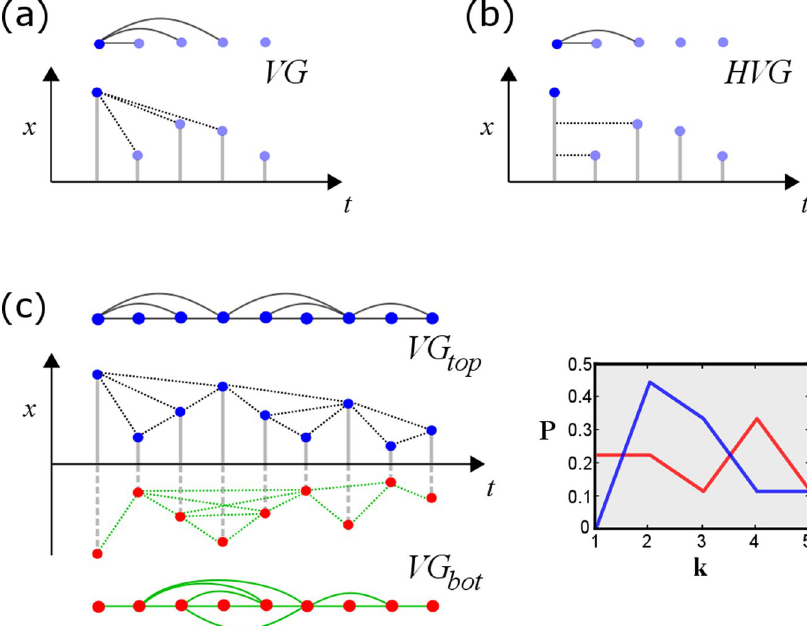
Figure 1. (Panels a and b) Sample time series and associated natural visibility (VG, panel a) and horizontal visibility (HVG, panel b) linking criteria. Each mapping is invariant under a certain number of transformations (VG is invariant under affine transformations x → ax + b , a > 0, HVG is invariant under monotonic transformations x → f ( x ), f ( ⋅ ) an order-preserving function). (Panel c) Sample time series and extraction of the top natural visibility graph (black) and bottom natural visibility graphs, which characterise the visibility structure of local maxima (top) and local minima (bottom) respectively. Note that G top coincides with a standard visibility graph of series x ( t ), and G bot { x ( t )} ≡ G top { − x ( t )}, that is, characterization of local minima is achieved by extracting the visibility graph from the inversed series − x ( t ). One can extract features from both G top and G bot (here, a cartoon of the degree distribution P ( k )) and compare these as a proxy to the comparison between local minima and local maxima